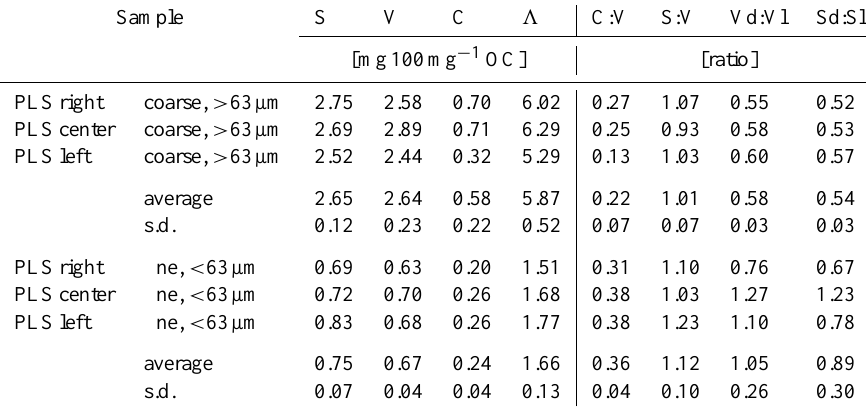
Table 2. Lignin biomarkers of Po river suspended samples collected at Pontelagoscuro (PLS).